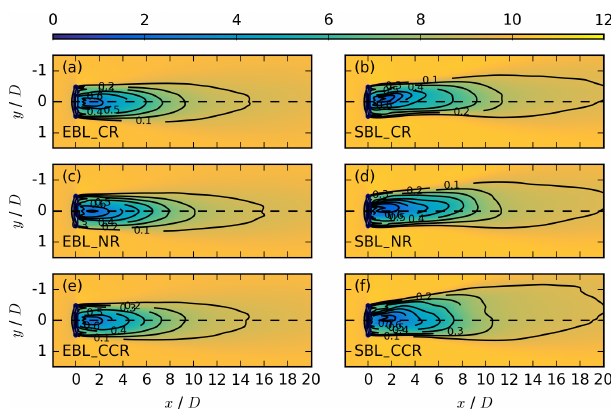
in Figure 8. Coloured contours of the streamwise velocity u i,j,k h metres per second at hub height k h , averaged over the last 50min, for EBL_CR in (a) , SBL_CR in (b) , EBL_NR in (c) , SBL_NR in (d) , EBL_CCR in (e) , and SBL_CR in (f) . The black contours rep- in Figure 10. Coloured contours of the streamwise velocity u i,j,k resent the velocity deficit VD i,j,k at the same vertical location. ∗ h metres per second at z = 75m with index k ∗ , averaged over the last 50min, for the same cases as in Fig. 8. The black contours represent the velocity deficit VD i,j,k at the same vertical ∗